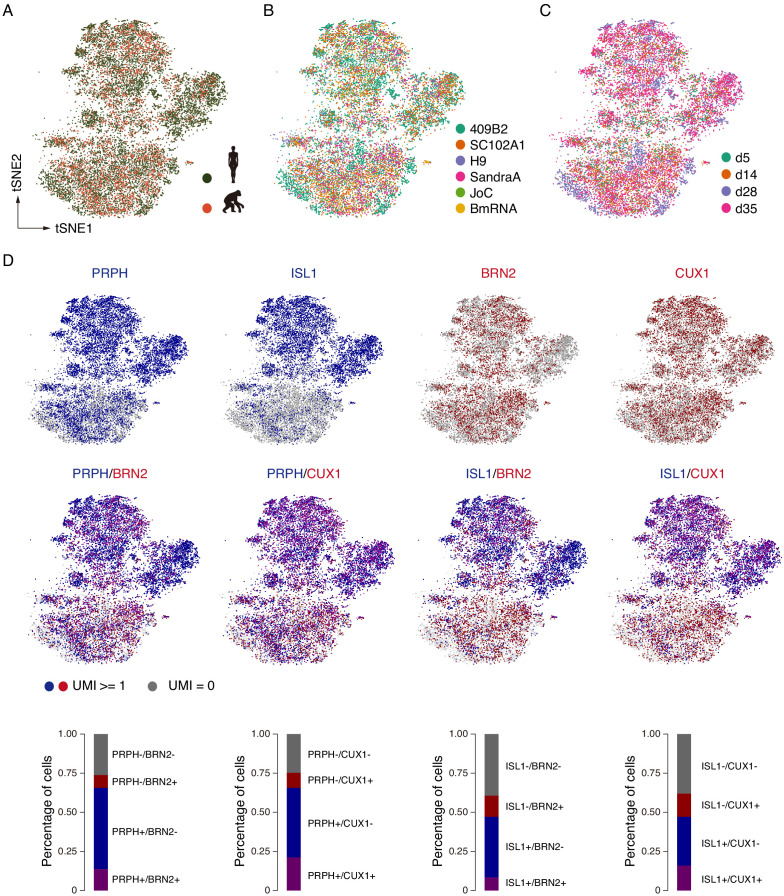
scRNAseq revealed that NGN2 induces cortical and sensory neuron fates.(A–C) tSNE plots showing single iNs from each species (A) and cell line (B) at each time point (C). (D) scRNAseq analysis reveals that NGN2-induced iNs express both sensory neuron markers as well as cortical markers. Cell identity and heterogeneity was assessed using tSNE combined for all time points (d5, d14, d28 and d35) and ape and human cells together. Marker gene expression for single markers or a combination of sensory and cortical markers. Sensory neurons are shown in blue (PRPH and ISL1) and cortical markers are shown in red (BRN2 and CUX1). Quantifications show that around 66% of the neurons are PRPH positive: 22% of neurons are BRN2 positive and 13.7% of cells are PRPH and BRN2 positive; 31% of cells are CUX1 positive and 21.2% of cells are PRPH and CUX1 positive. Quantifications show that around 47% of neurons are ISL1 positive: 8.3% of cells are ISL1 and BRN2 positive; 15.9% of cells are ISL1 and CUX1 positive, suggesting that the system consists of sensory and cortical neurons and possibly of cortical sensory neurons.